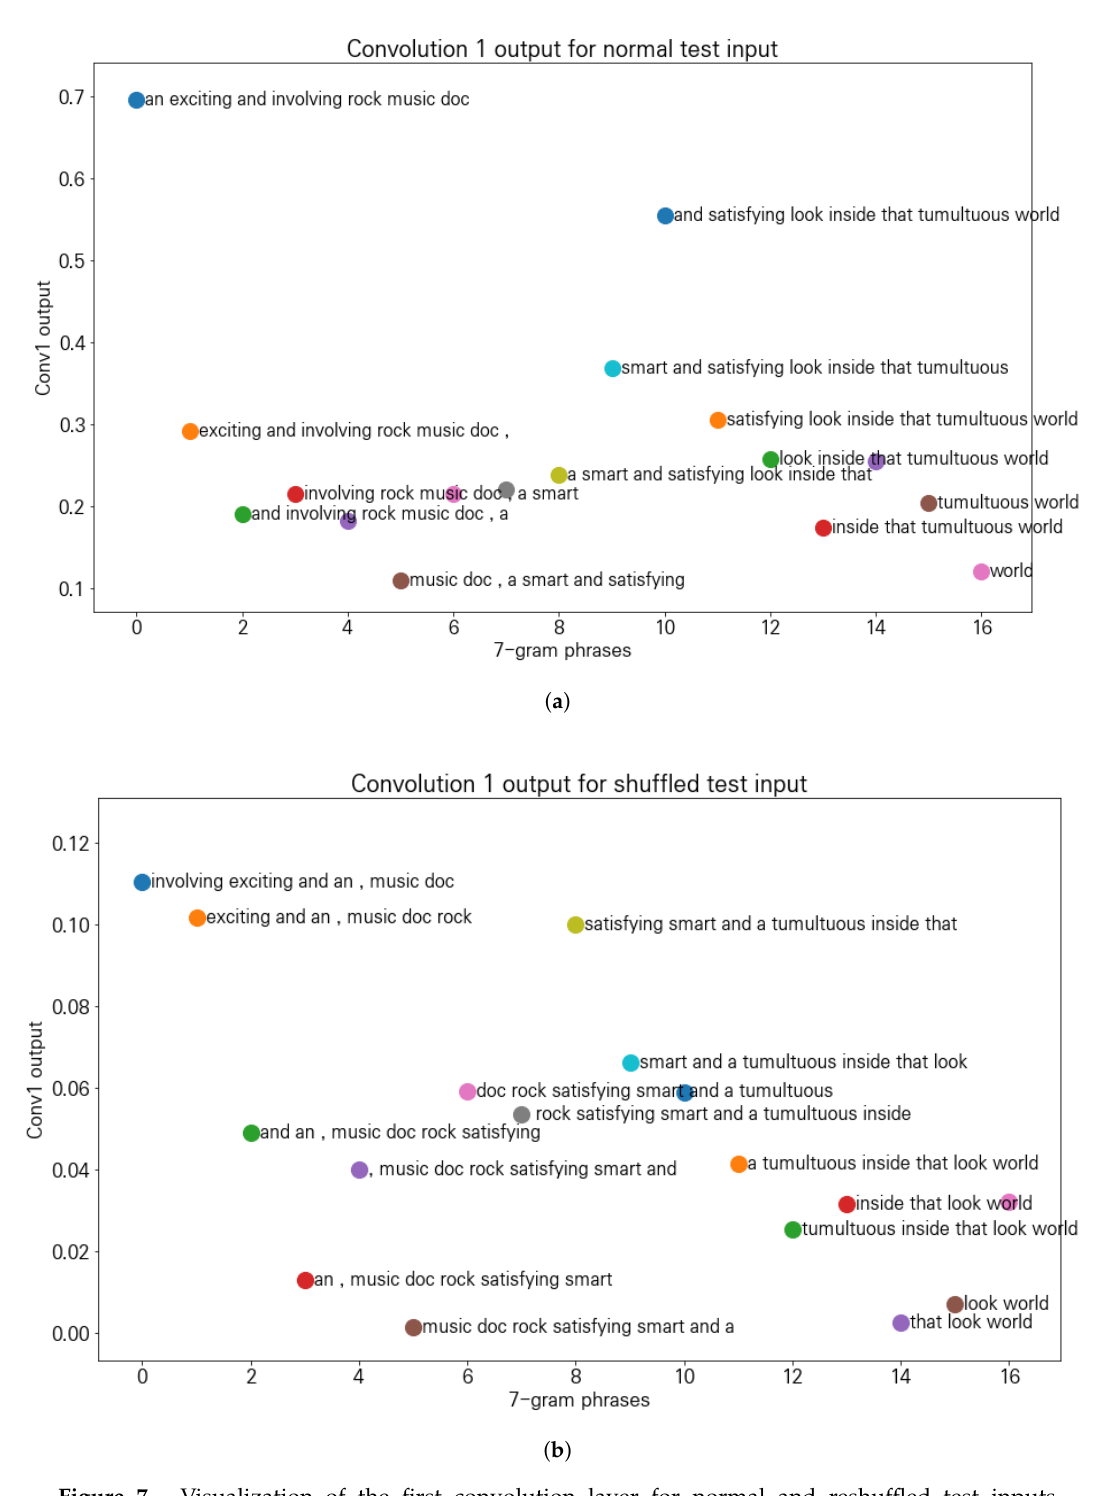
Figure 7. Visualization of the first convolution layer for normal and reshuffled test inputs. ( a ) convolution layer 1 output: Normal test input; 7-grams that contain much polarity information have higher outputs; ( b ) convolution layer 1 output: shuffled test input. No significant difference in the output between 7-grams that contain enough polarity information and those which do